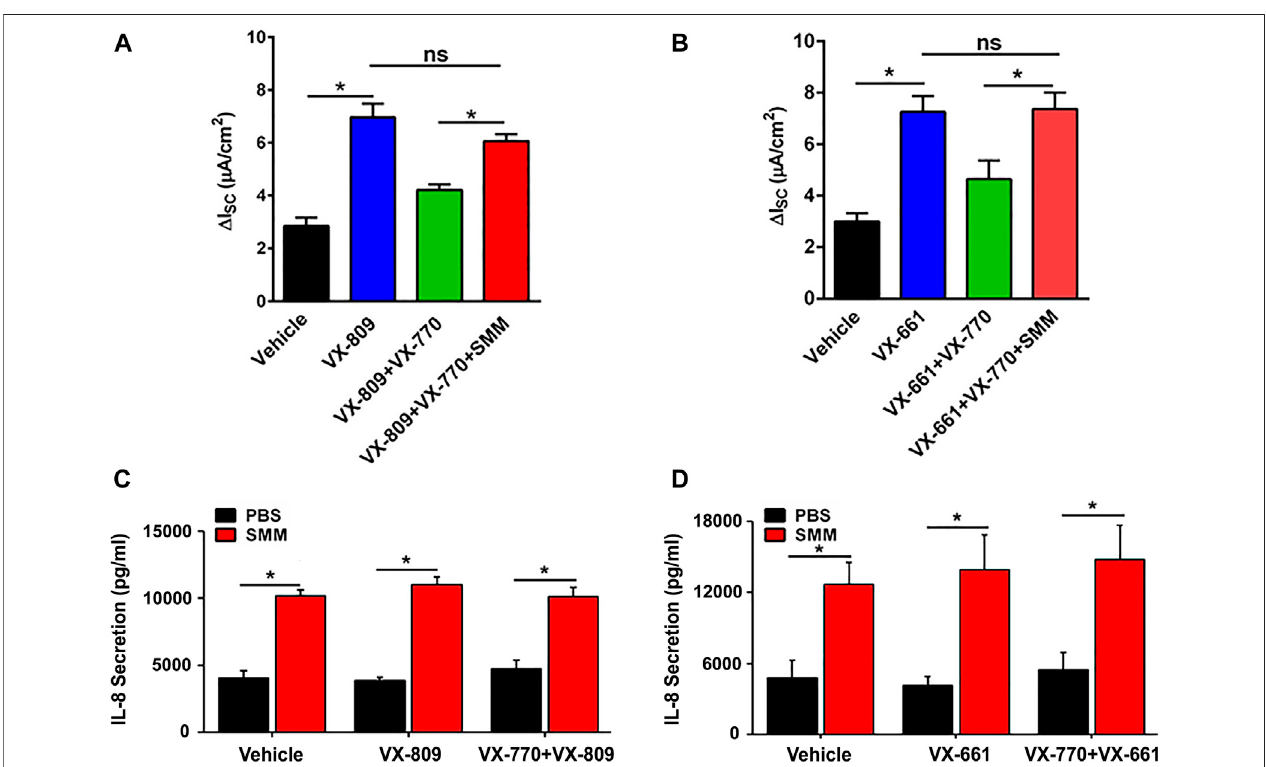
FIGURE2| SMMovercomeschronicVX-770treatment-promotedinhibitionofF508delrescue.F508delCFTRresponsesweremeasuredinUssingchambers. (A) SMM overcomes chronic VX-770 (5 μ M, 48 h)-mediated abrogation of VX-809-promoted rescue. (B) SMM overcomes chronic VX-770 (5 μ M, 48 h)-mediated abrogation of VX-661-dependent rescue. (C) , (D) IL-8 secretion from F508del/F508del HBE cultures exposed to PBS or SMM and treated for 48 h with VX-809 (C) or VX-661 (D) ± VX-770. Data are expressed as mean ± SEM. *p < 0.05, ns (cid:2) not signi fi cant; n (cid:2) 3 CF HBE donors, three cultures/donor.